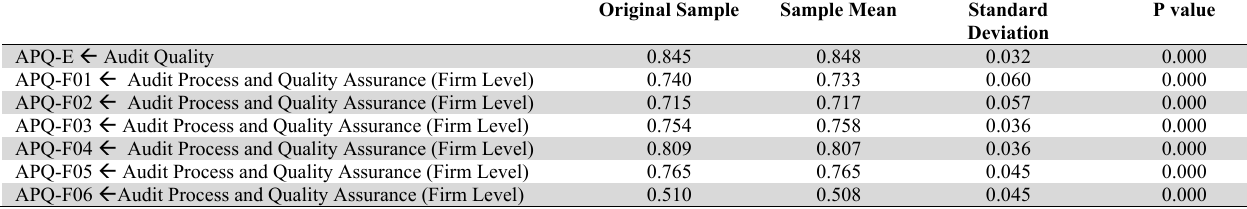
The Manifestation of Attributes of Audit Process and Quality Assurance for Firm (Public Accounting Firm) Level Original